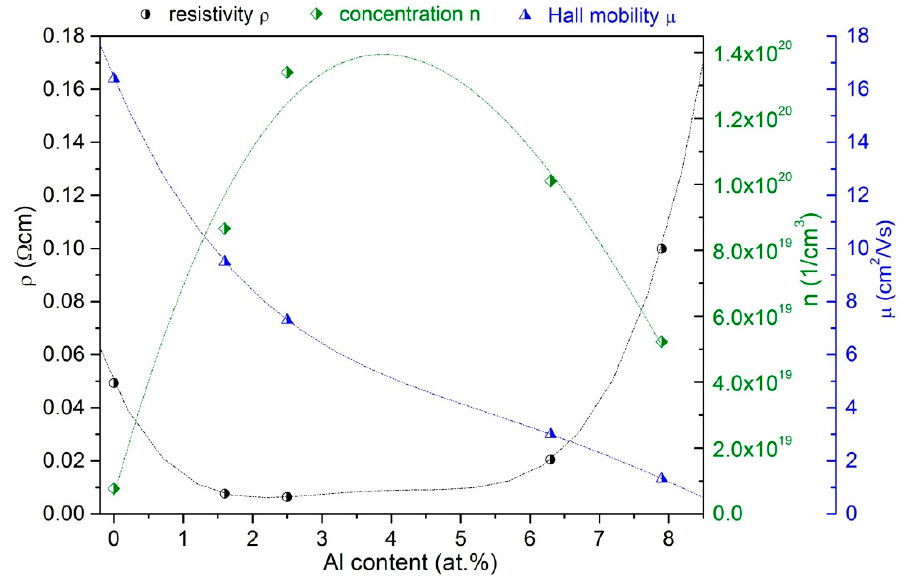
Figure 6. Dependence of electrical resistivity ρ , carrier density n and Hall mobility µ on Al content in the AZO films.